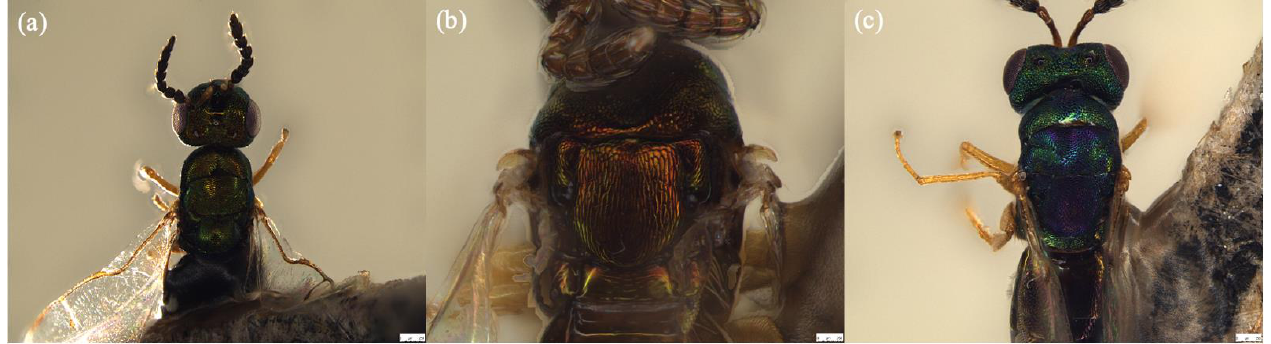
Figure 6. Mesosoma, dorsal view of ( a ) Sycoscapter chinensis sp. n.; ( b ) S. thaiensis sp n.; and ( c ) S. singaporensis sp. n. Noted that S. singaporensis has body color of metallic green with blue reflection. Scale bars represent 250 μm.